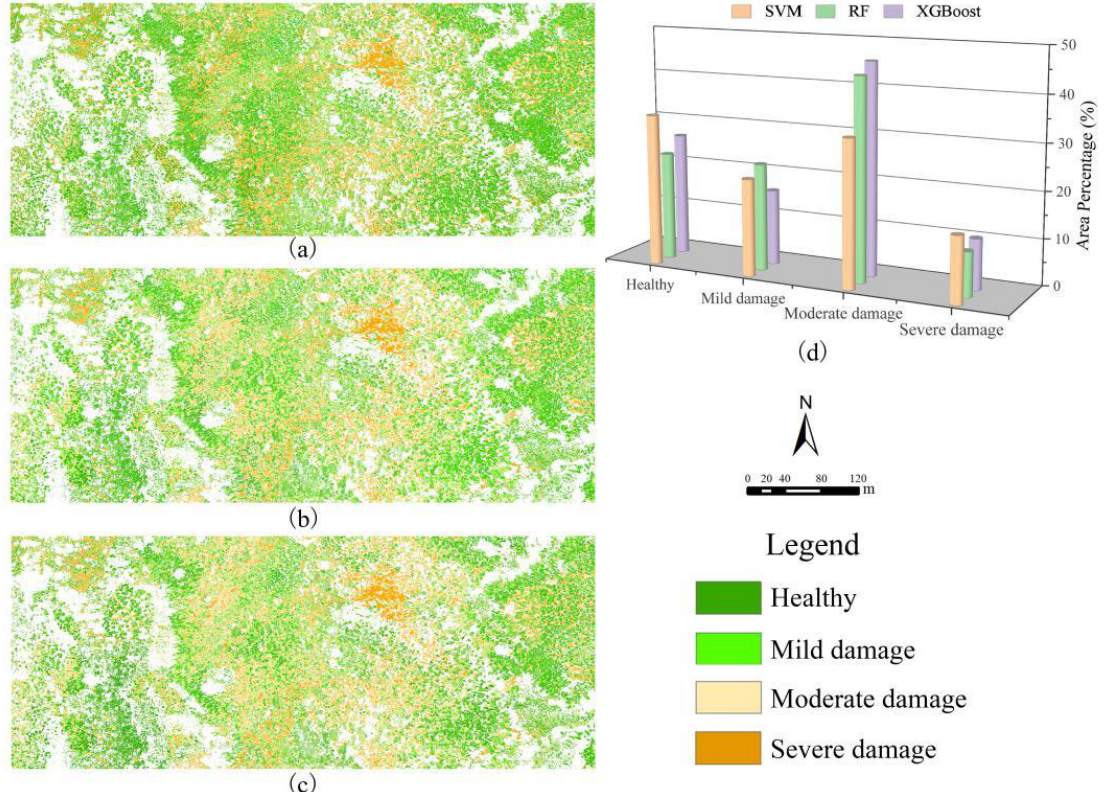
Figure 6. Prediction of the damage level of PPC based on three machine learning algorithms: ( a ) prediction results of SVM classification algorithm; ( b ) prediction results of RF classification algorithm; ( c ) prediction results of XGBoost classification algorithm; ( d ) the ratio of the area occupied by each damage level according to the three models.